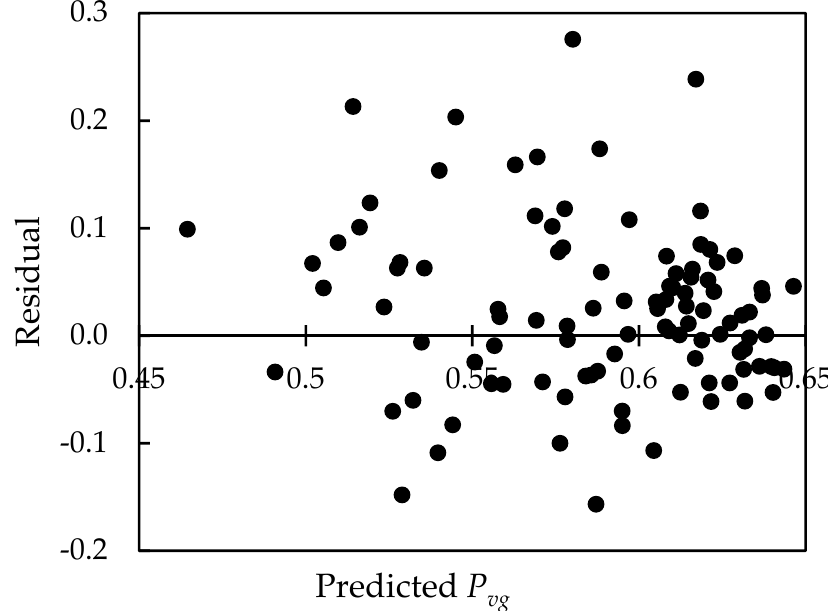
Figure 10. The residual plot of the estimated P vg-c and n × d 2 .